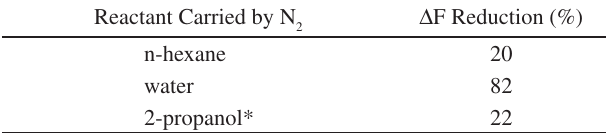
Table 6. Reduction of ∆ F on percentages obtained using the chicane with 2-propanol plasma film deposited on it. Setup without chicane it was used as reference.